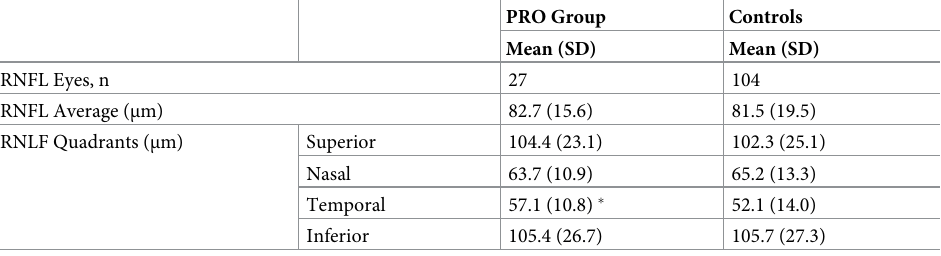
Table 2. RNFL thickness measurements recorded from SD-OCT optic disc and macular cube scan protocols. One-sided Welch T-test was used to determine significance. The data demonstrate a statistically significant difference in RNFL thickness between PRO and control groups in the temporal quadrant.